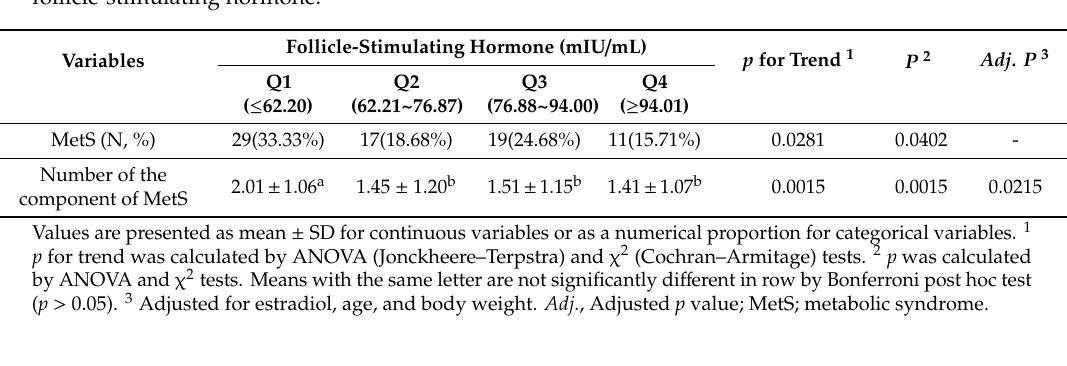
Table 4. Associations between follicle-stimulating hormone and metabolic syndrome in post- menopausal women.